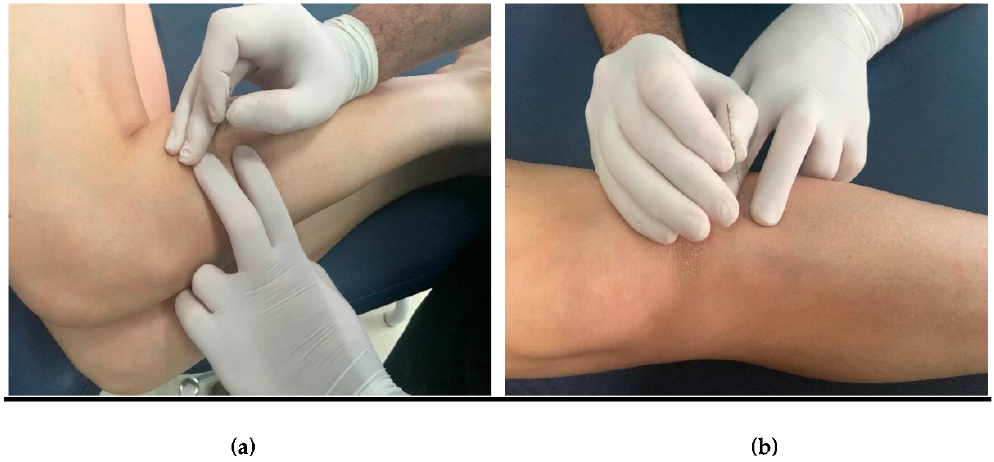
Figure 3. Dry needling of Peroneus Longus (PL) and Tibialis Anterior (TA). ( a ) for PL, the subject was placed in the lateral decubitus position on the non-assessed side with hips and knees flexed to 90 degrees. The physiotherapist remained in front of the patient and inserted the needle perpendicularly from lateral to medial. ( b ) for TA, the subject was placed in supine and the physiotherapist was positioned ipsilateral on the treatment side to guide the needle in an anterior-posterior and slightly medial direction towards the tibia.